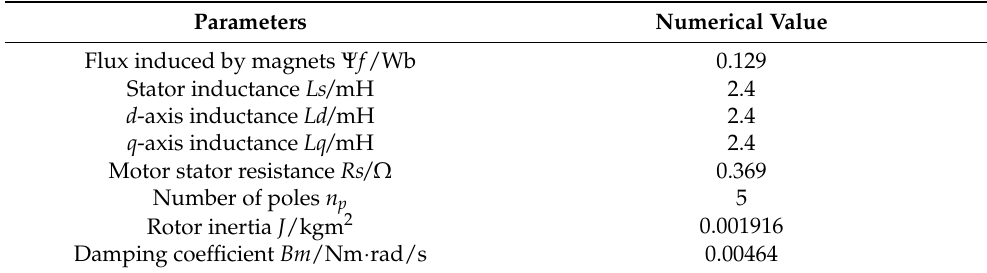
Table 1. Nominal parameters of PMSM.